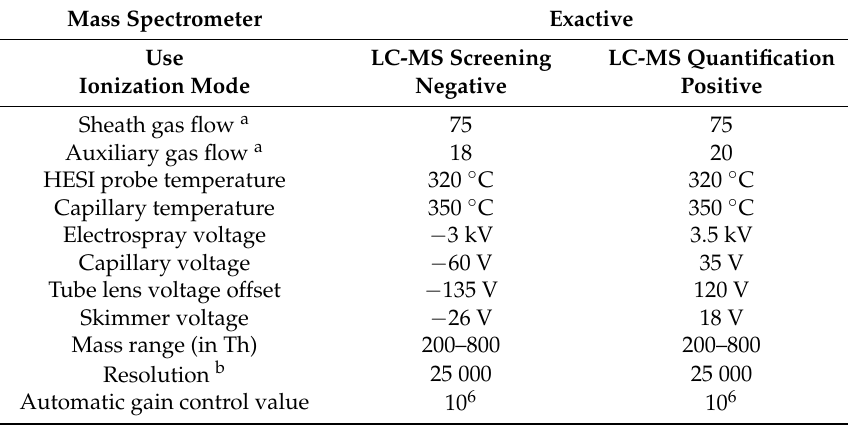
Table 2. Ionization and spectrometric conditions for HRMS